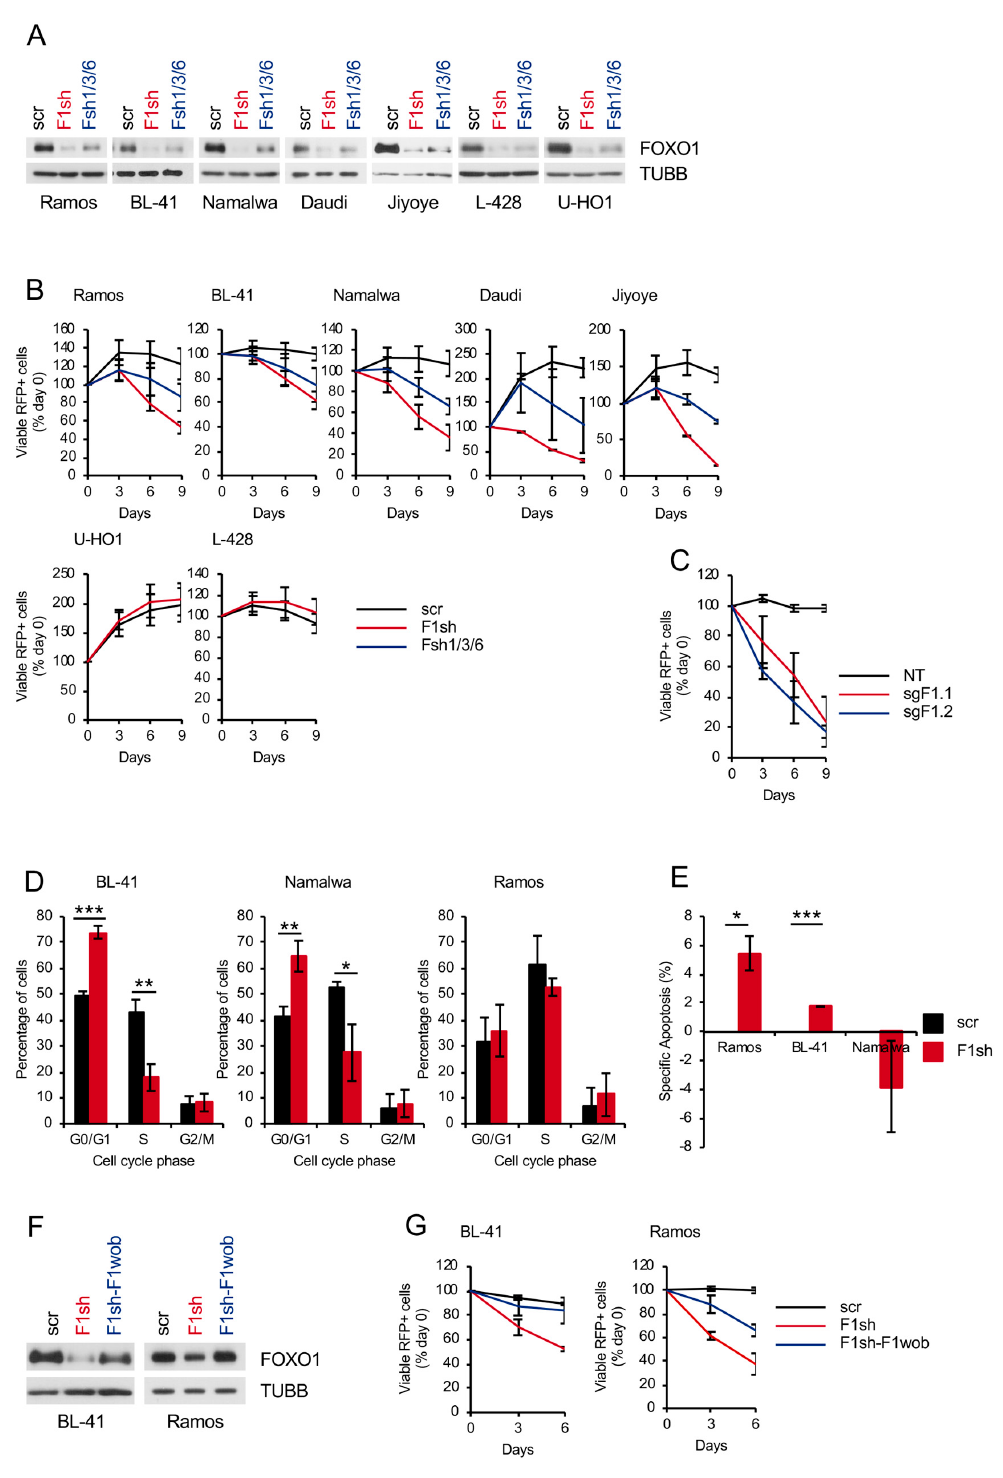
Figure 1. FOXO1 knockdown negatively regulates proliferation of BL cell lines. ( A , B ) BL and cHL cell lines were transduced with lentiviral vectors expressing FOXO1 shRNA (F1sh) or FOXO shRNA1 / 3 / 6 (Fsh1 / 3 / 6) vs. scrambled (scr) control. ( A ) Knockdown e ffi ciencies of F1sh and Fsh1 / 3 / 6 vs. scr control. Transduced cells were selected for 2 days using 4 µ g / mL puromycin and FOXO1 expression was analyzed 5–6 days post transduction. Expression of TUBB served as loading control. A representative of 2–3 independent experiments is shown. ( B ) Growth dynamics of transduced BL and cHL cell lines. The percentage of RFP + cells was measured every 3 days using flow cytometry starting from day 4